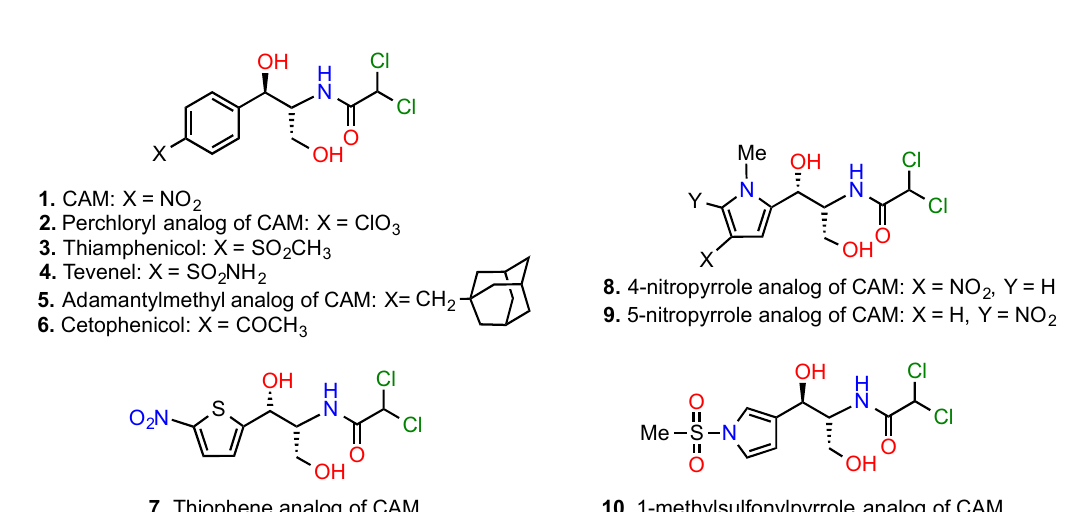
Figure 5. Analogs of CAM derived through modification or replacement of the p -nitrobenzene moiety. An effort by Mullen and Georgief to replace the nitro group of CAM with a bulky nonpolar substituent, namely the adamantylmethyl group (compound 5 ), was detrimental for